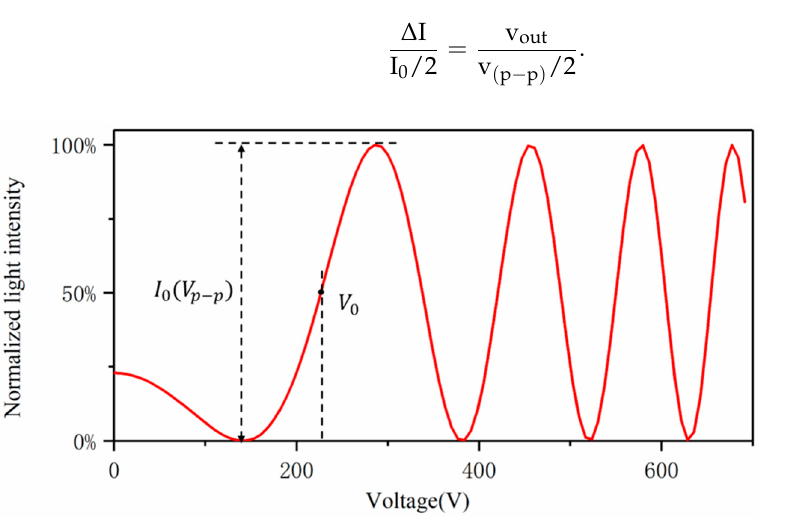
Figure 5. Light intensity modulation curve when a sinusoidal voltage of 0 to 700 V is applied at 15